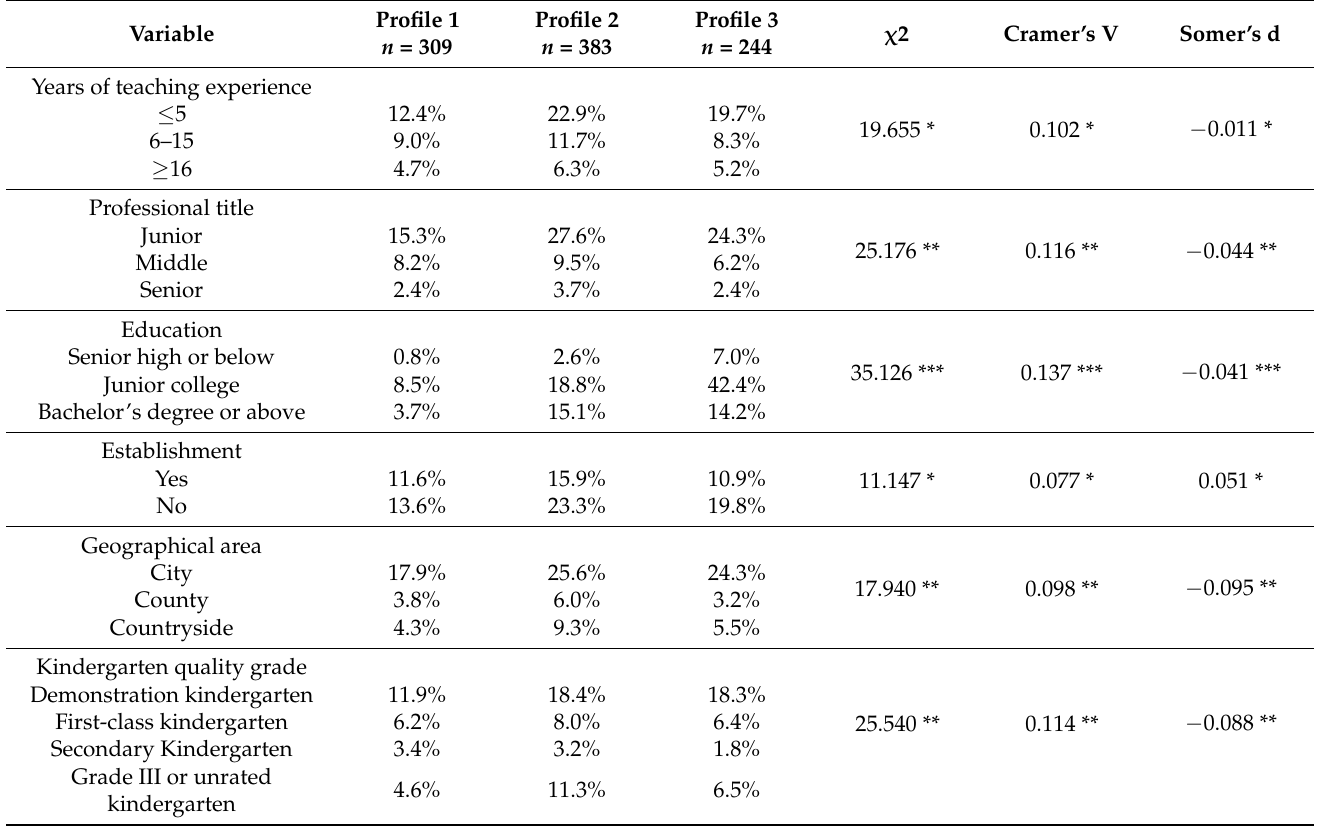
Table 5. Demographic characteristics in terms of the three